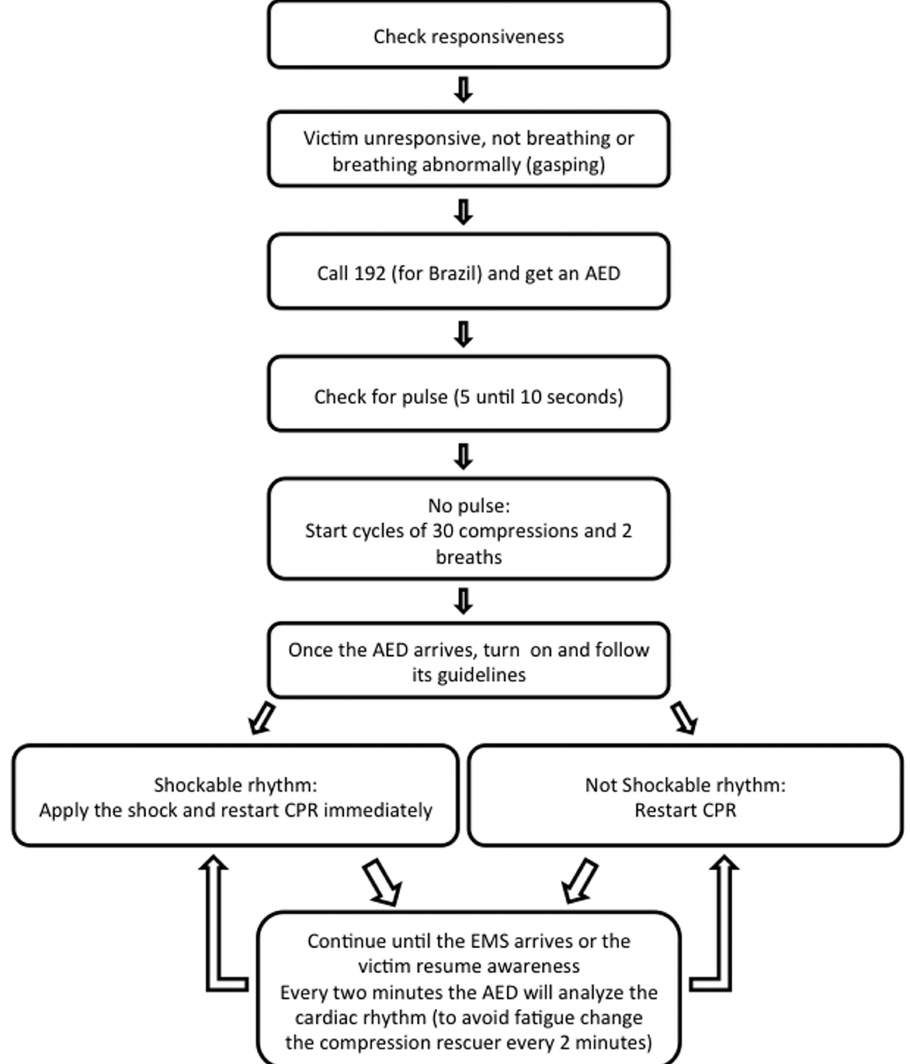
Figure 1 - Current recommendations for cardiac support (Basic